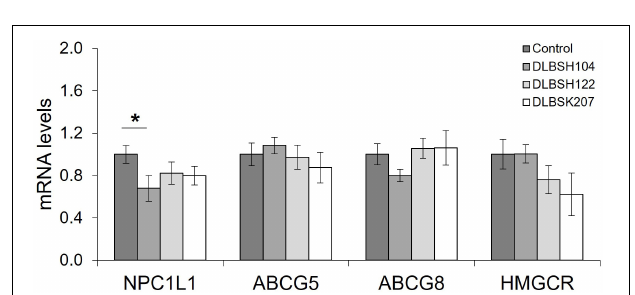
FIGURE 4 | Cell viability of Caco-2 treated with potential Lactobacillus strains for 20 h. Caco-2 was treated with 3 potential LAB strains with several concentrations (1 × 10 6 –1 × 10 9 CFU/ml). Then, the cell viability of Caco-2 after treatment was assessed by MTT assay. The result is expressed as mean ± SD of at least three independent experiments. Statistical analysis was determined by using one-way ANOVA.